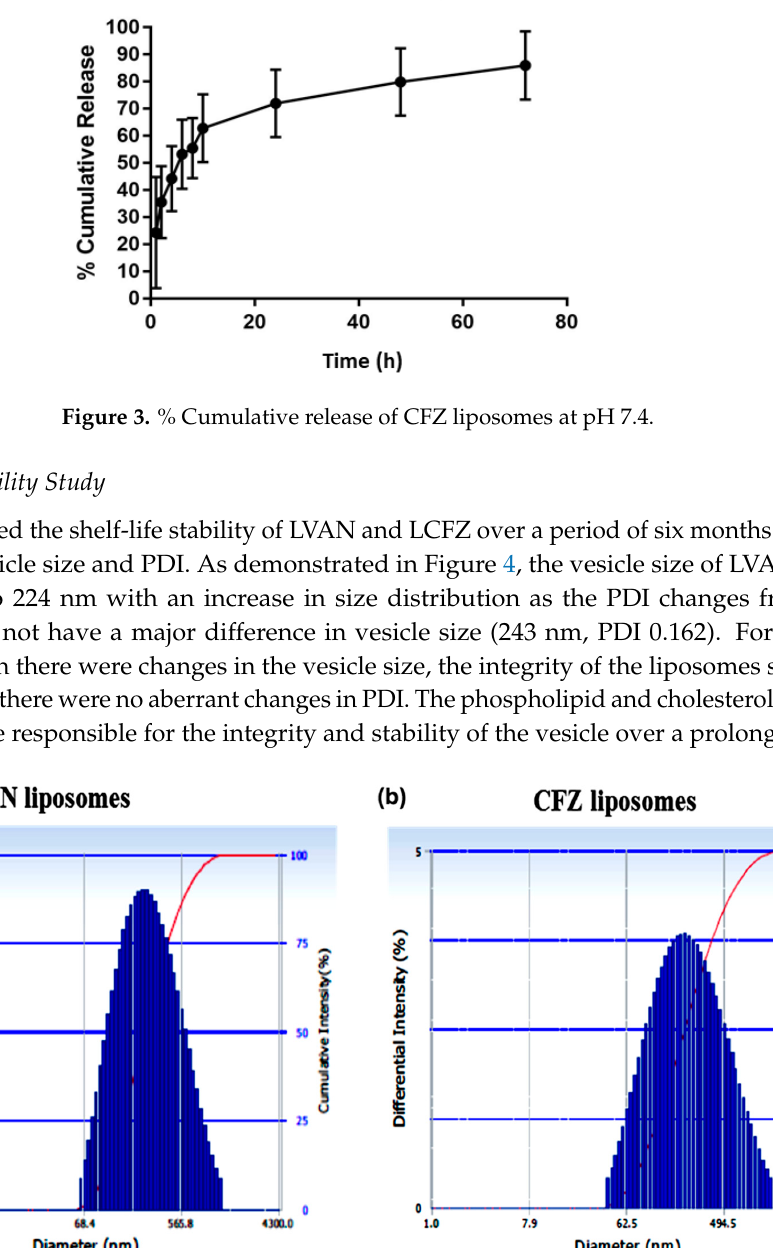
Figure 4. Histograms of vesicle size of ( a ) VAN liposomes and ( b ) CFZ liposomes after six months of shelf-storage.